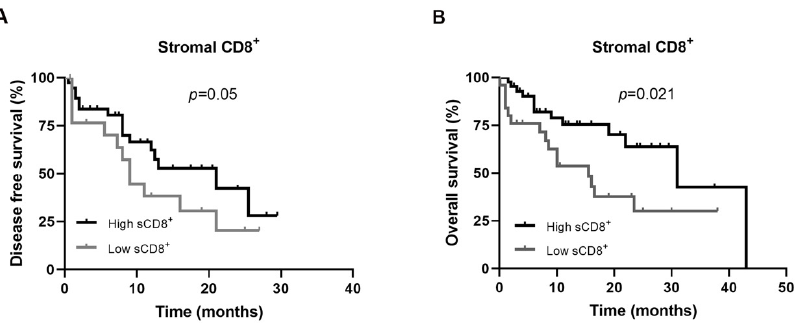
Figure 2. Disease free survival and overall survival of cats with mammary carcinoma according to low or high expression of CD8 + receptors in immune cells of tumor microenvironment. Kaplan-Meier curves for association of stromal CD8 + T lymphocytes with ( A ) disease free survival, and with ( B ) overall survival.